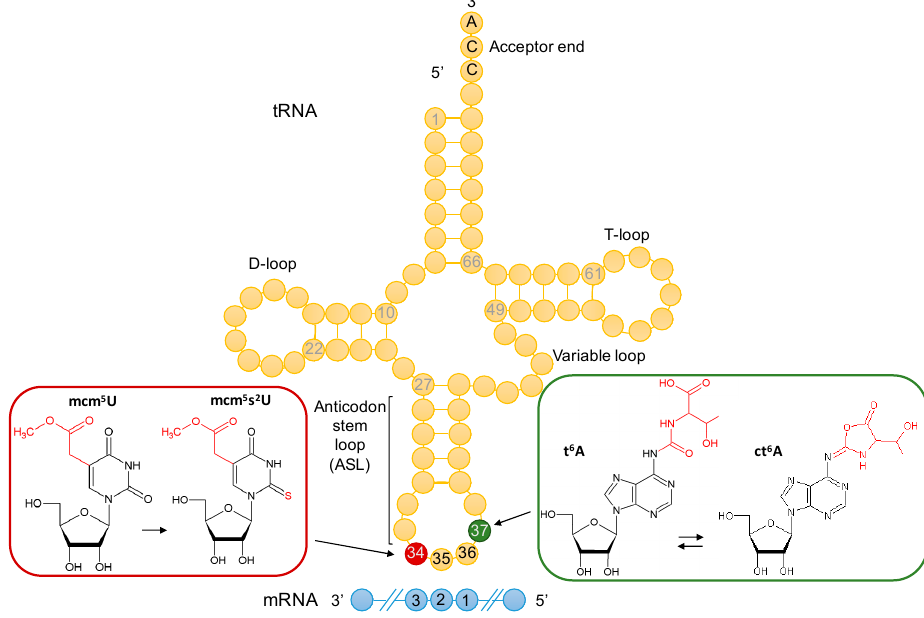
Figure 1. Anticodon-stem-loop (ASL) modifications in yeast tRNA. At the wobble position 34 (in red), 5-methoxycarbonyl-methyluridine (mcm 5 U) modifies tRNA Arg UCU , tRNA Gln UUG , tRNA Glu UUC and tRNA Lys UUU , where it is further thiolated to 5-methoxycarbonyl methyl-2-thiouridine (mcm 5 s 2 U). Adjacent to the anticodon, at position 37 (in green), N 6 -threonyl-carbamoyl adenosine (t 6 A) modifies tRNAs that decode ANN codons (positions 1, 2, 3 of the mRNA codon) and is further modified to ct 6 A in several tRNAs. The tRNA molecule in yellow shows anticodon positions 34, 35, and 36. The mRNA molecule in blue highlights codon positions 1, 2, and 3. The structures of the modified bases were obtained from the Modomics database [31].